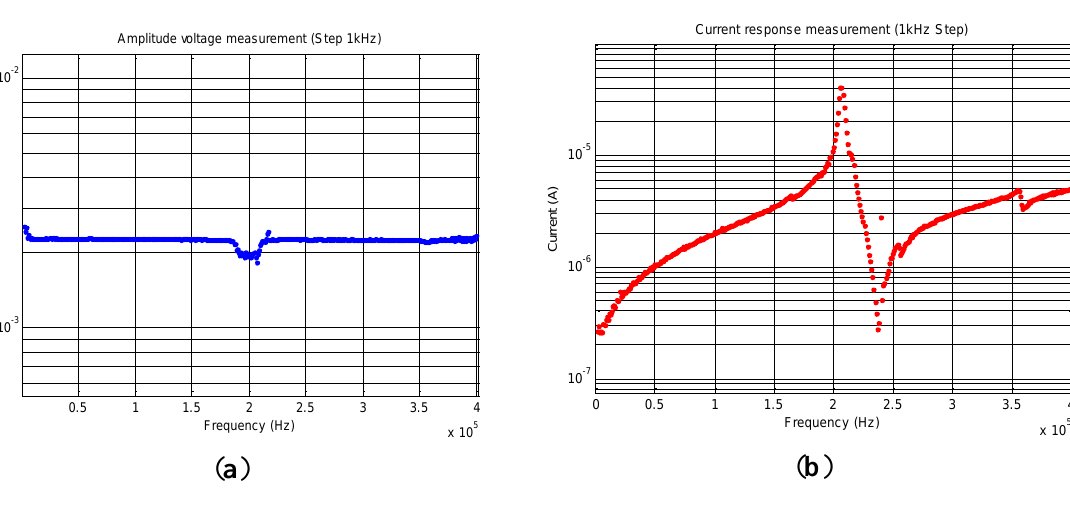
Figure 16. ( a ) V (f): Measurement of PZT voltage amplitude after each frequency PZT incrementation. The measurement was performed between 0 and 400 kHz with a step of 1kHz ( b ) I (f): Measurement of PZT current response amplitude for each frequency PZT incrementation between 0 and 400